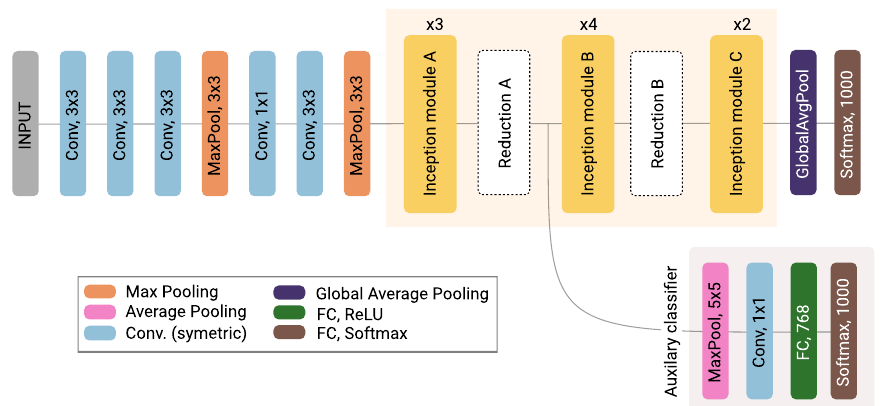
Figure 5. InceptionV3